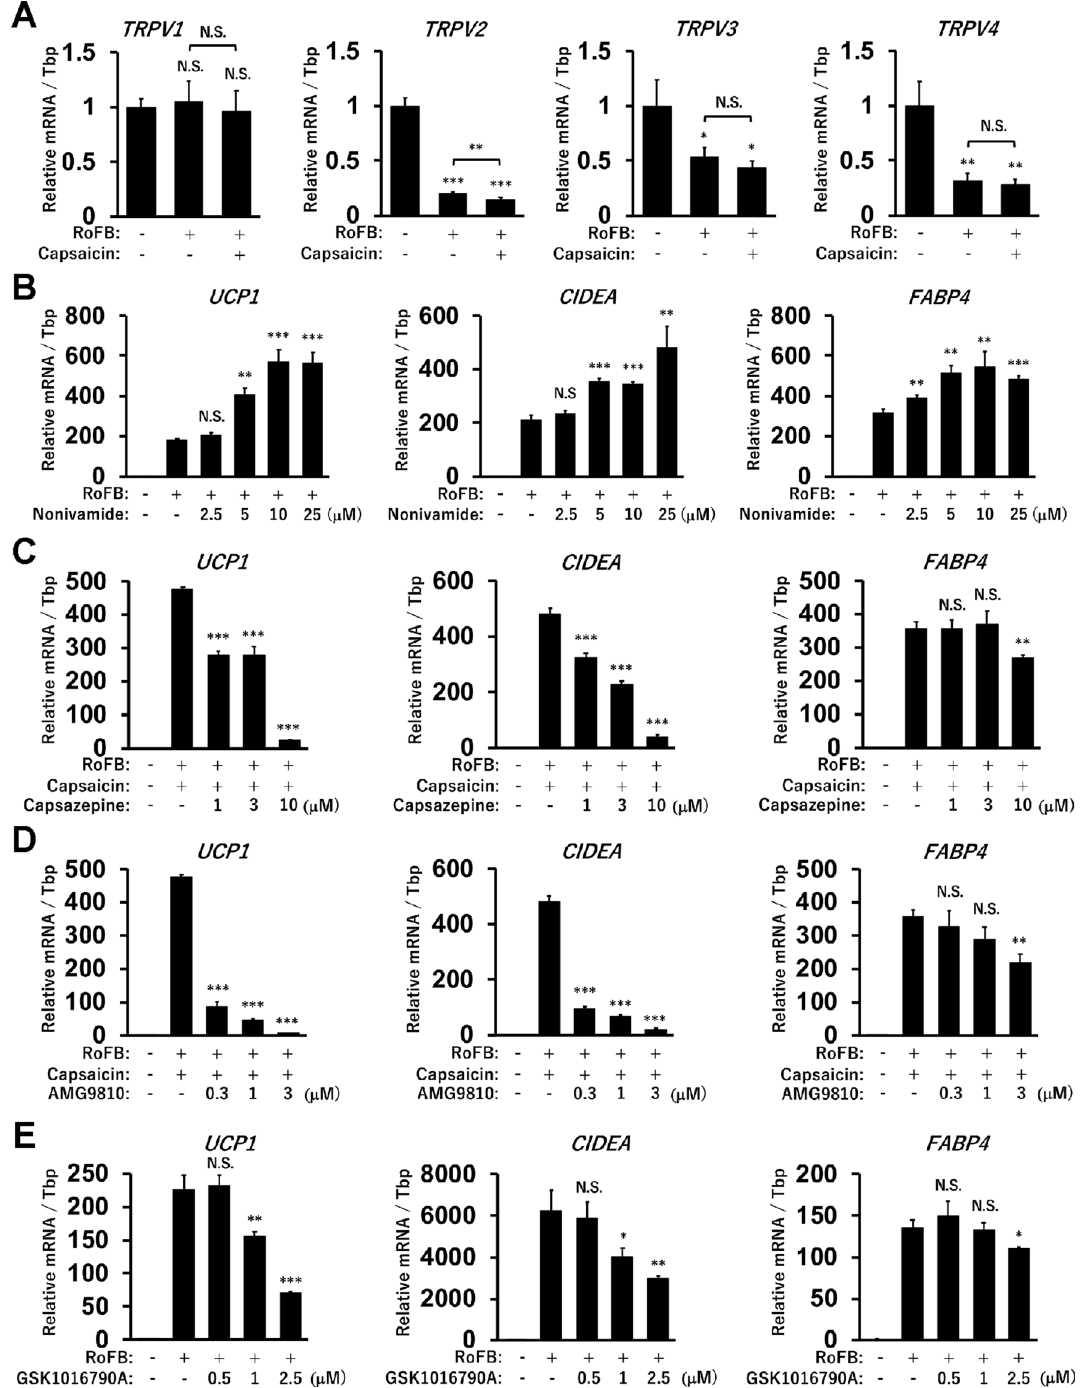
Figure 3. Effects of agonists and antagonists for TRPV1 and TRPV4 in ciBAs. ( A ) The expression of four TRP channels was quantified by qRT-PCR in the control, ciBAs, and Capsaicin-treated ciBAs. ( B–E ) The expression of UCP1 , CIDEA , and FABP4 was quantified in ciBAs induced in the presence of Nonivamide ( B ), Capsaicin and either Capsazepine ( C ) or AMG9810 ( D ), and GSK1016790A ( E ) at different concentrations as indicated. Data represent mean ± SD (n = 3). Student’s t -test: * P < 0.05, ** P < 0.01, *** P < 0.001, N.S.; not